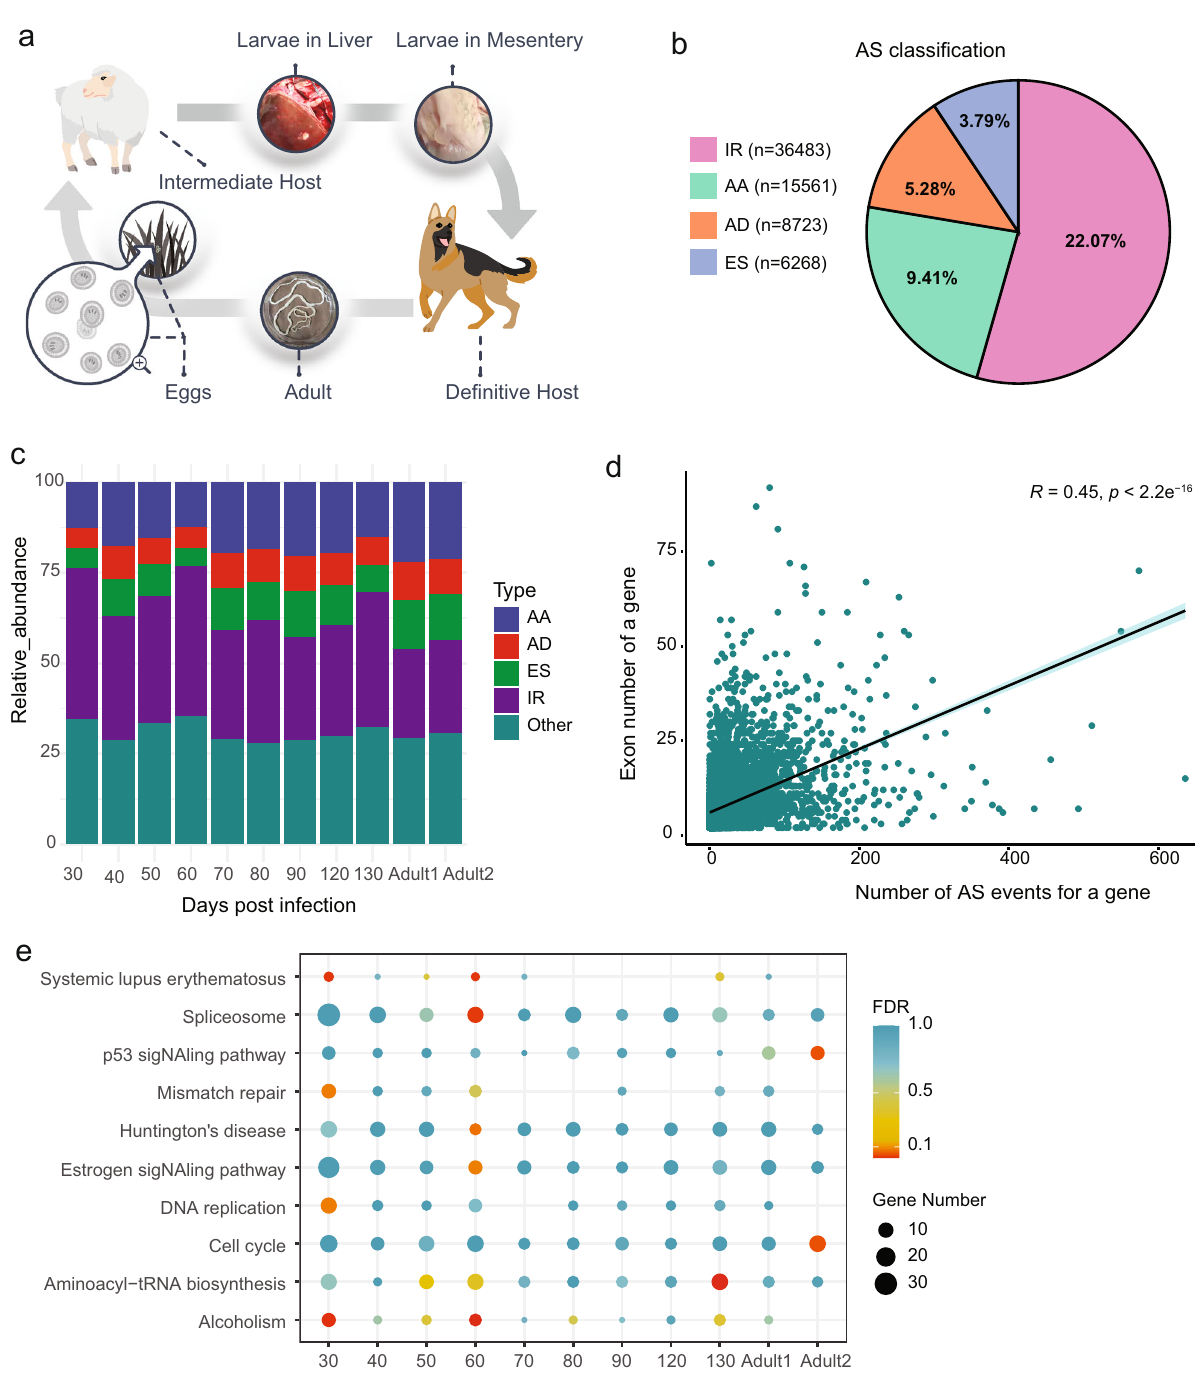
Fig. 3 Extensive alternative splicing events in transcriptomes. a The typical life cycle for T. hydatigena . Its complete life cycle starts from eggs that are consumed by intermediate host (e.g., sheep). Larvae penetrate the wall of host intestine, and typically migrate to the liver and then mesentery/omentum, where they develop into fl uid- fi lled bladder-like cysts. The adult tapeworms in canids (e.g., dogs) produce proglottids that are then passed in the feces. b Alternative splicing event types identi fi ed in the genome. The diagram represents the percentage of each alternative splicing category (intron retention [IR], alternative acceptor sites [AA], alternative donor sites [AD], and exon skipping [ES]). c Relative abundances of alternative splicing types for each sample of different developmental stages. The X -axis represents the tissues of larvae collected at days post infection or adults (Adult1 and adult2 represents samples of immature proglottids and mature proglottids, respectively). d Correlation between alternative splicing event number and exon number in the genome. R and p denote Pearson ’ s correlation coef fi cient (two-sided, con fi dence level = 0.95) and the corresponding p -value, respectively. e Enriched pathways of KEGG for the genes with abundant alternative splicing events. The genes that have more than 5 alternative splicing events detected in all the samples in RNA-seq analysis were used for the enrichment analysis. FDR was used to correct the multiple hypothesis